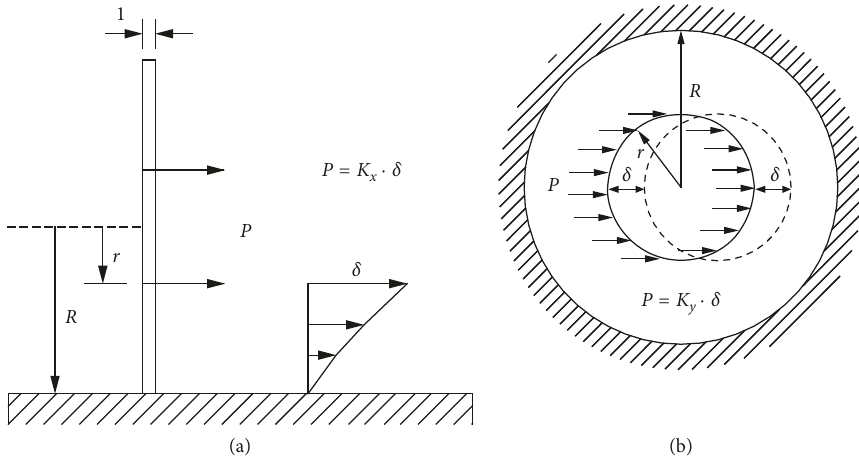
Figure 16: The model for calculating the isolation layer spring stiffness in (a) the longitudinal direction and (b) the transverse direction.